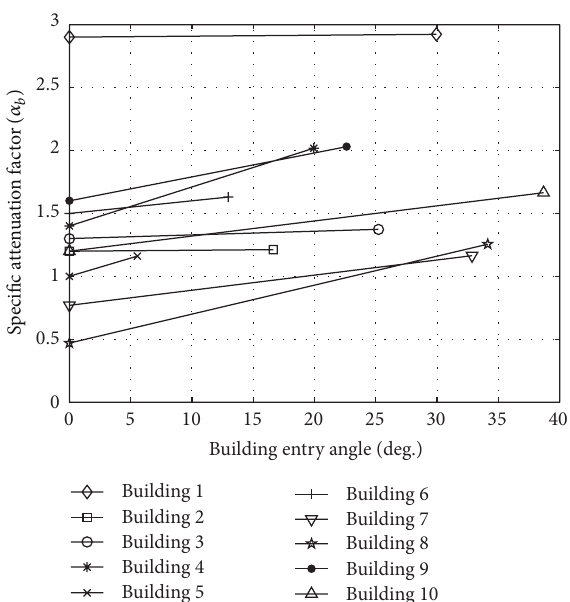
Figure 5: Linear approximations of 𝛼 𝑏 for all measurement sites.